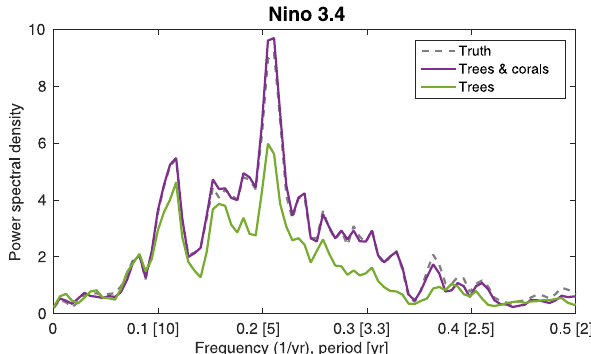
Figure 7. Power spectral density of the true model Nino 3.4 index time series along with the reconstructions based on pseudo-trees and pseudo-corals (purple) and pseudo-trees alone (green).